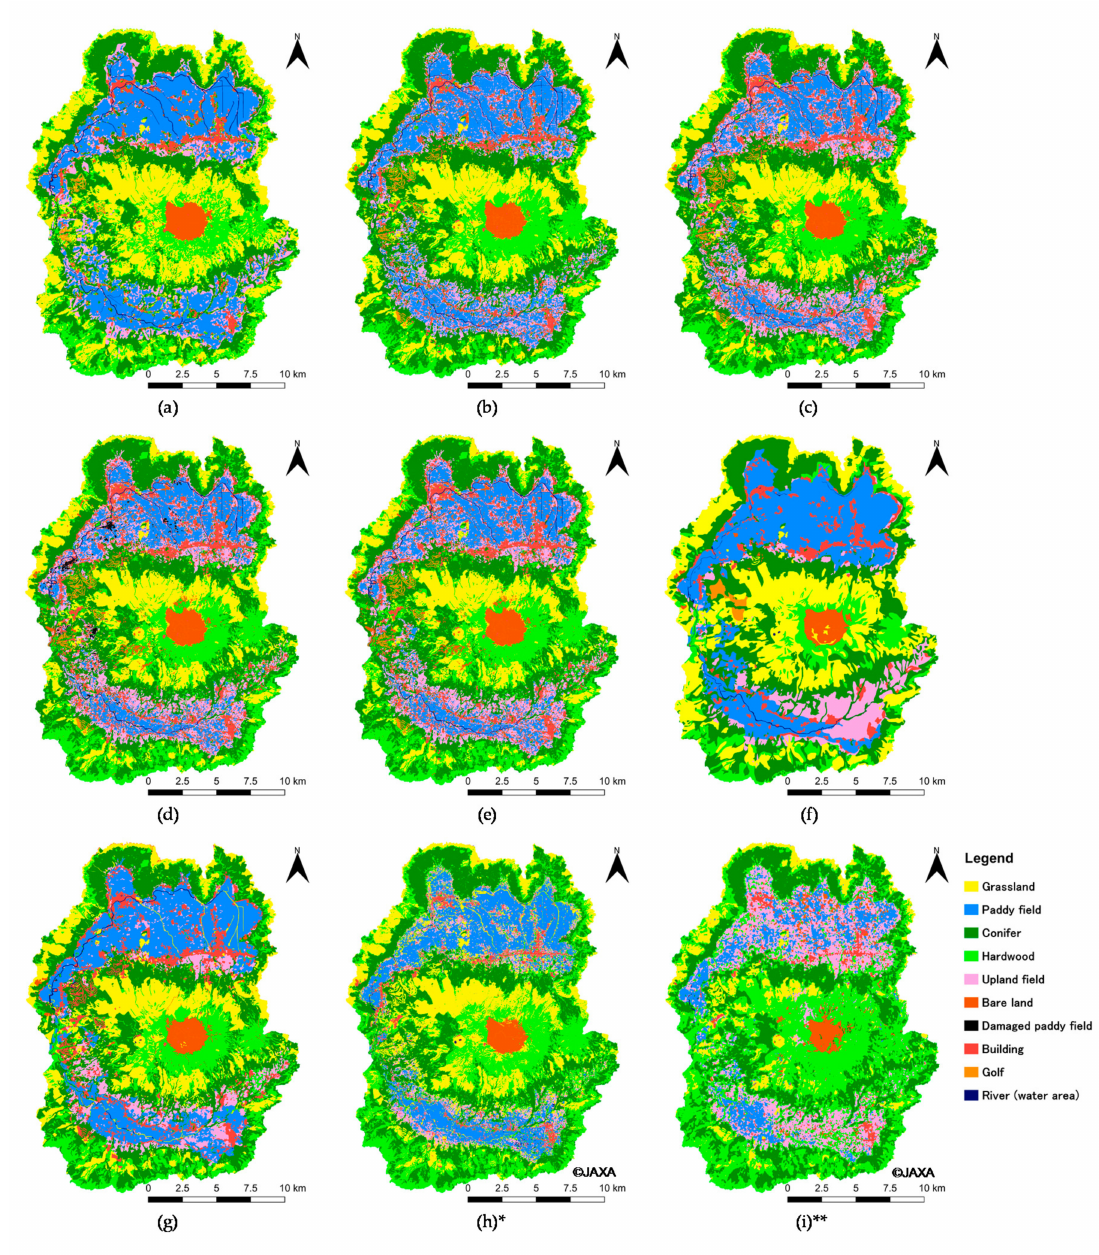
Figure 3. Land cover classification results and vegetation maps: ( a ) 1981, ( b ) 1996, ( c ) 2015, ( d ) 2016, ( e ) 2040s, ( f ) vg3, ( g ) vg67, ( h ) JAXA2006–2011 *, ( i ) JAXA2014–2016 **. * Provided by high-resolution land use and land cover 10 m resolution map of Japan [2006–2011] (ver.16.09: 10 categories) (Japan Aerospace Exploration Agency); ** Provided by high-resolution land use and land cover 30 m resolution map of Japan [2014–2016] (ver.18.03: 10 categories) (Japan Aerospace Exploration